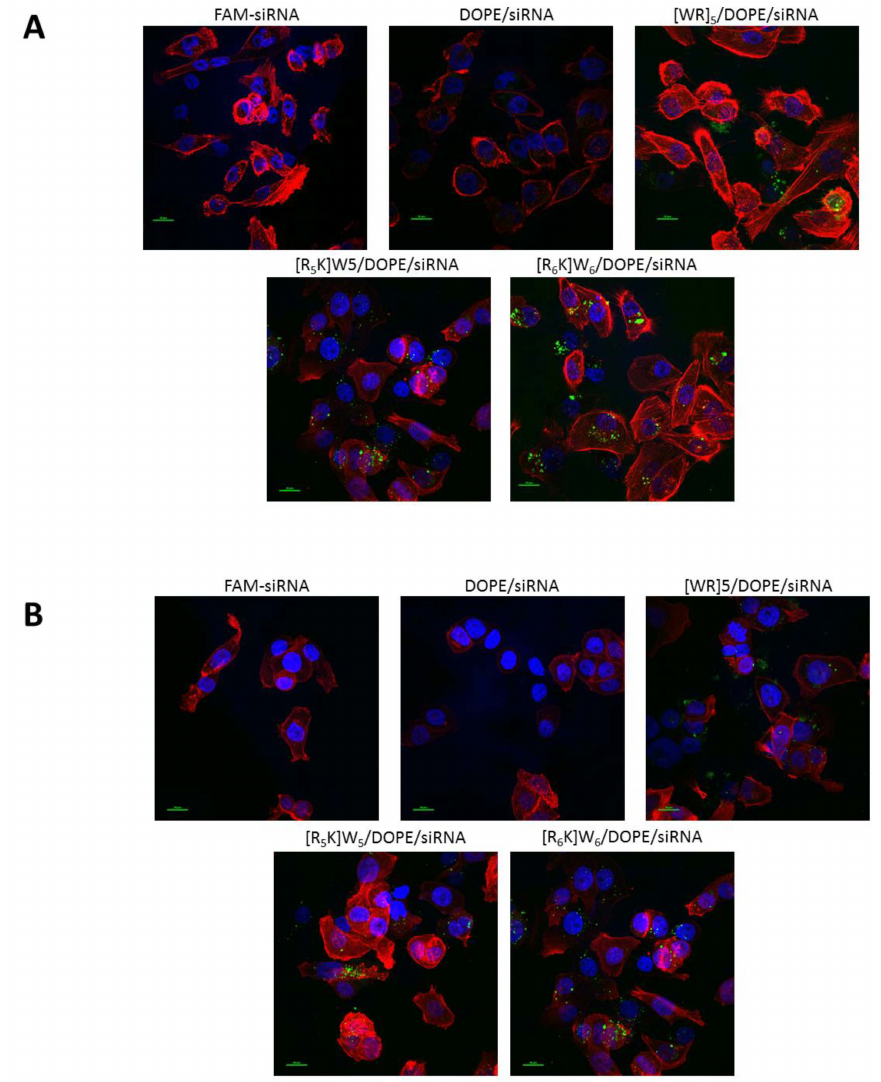
Figure 4. Confocal images of MDA-MB-231 ( A ) and MDA-MB-468 ( B ) cells exposed to FAM-labeled siRNA. The red, blue and green channels visualize Texas Red (used to stain the cell membrane), DAPI (stained the nuclei), and FAM-labeled